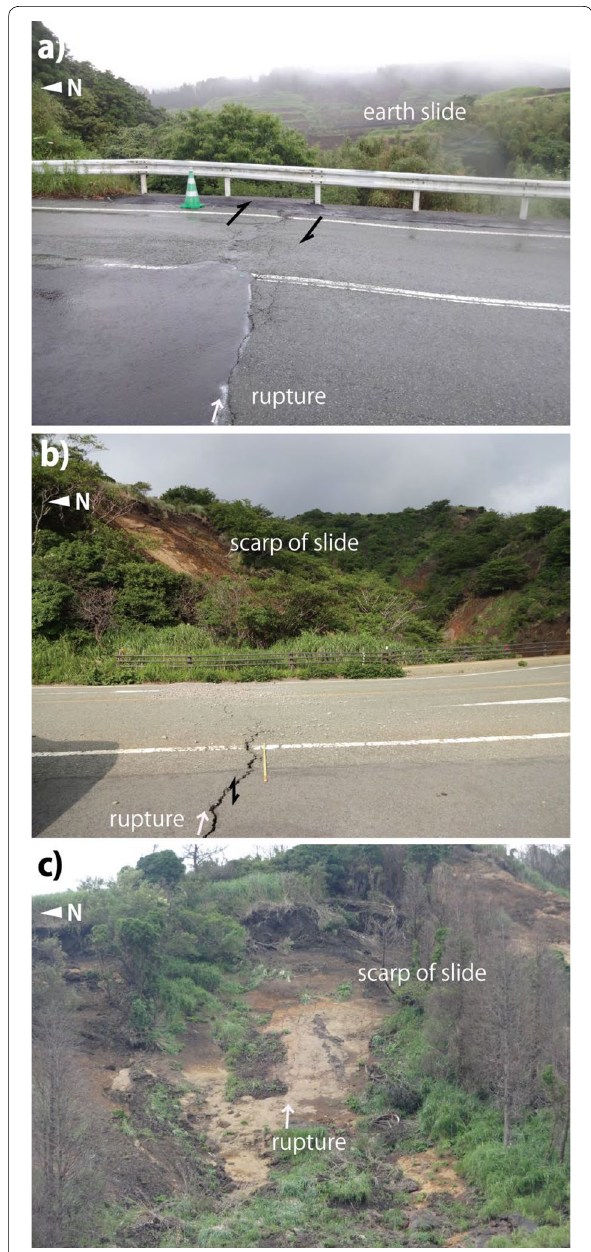
Fig. 9 Relationship of surface rupture and landslides. a Surface rupture with 5 cm right strike-slip extending to earth slides at Site 13. b Surface rupture with maximum 5 cm south side down extends to slides at north Hinoyama tunnel at Site 47. c Surface rupture in the scarp of slide at north Hinoyama tunnel at Site